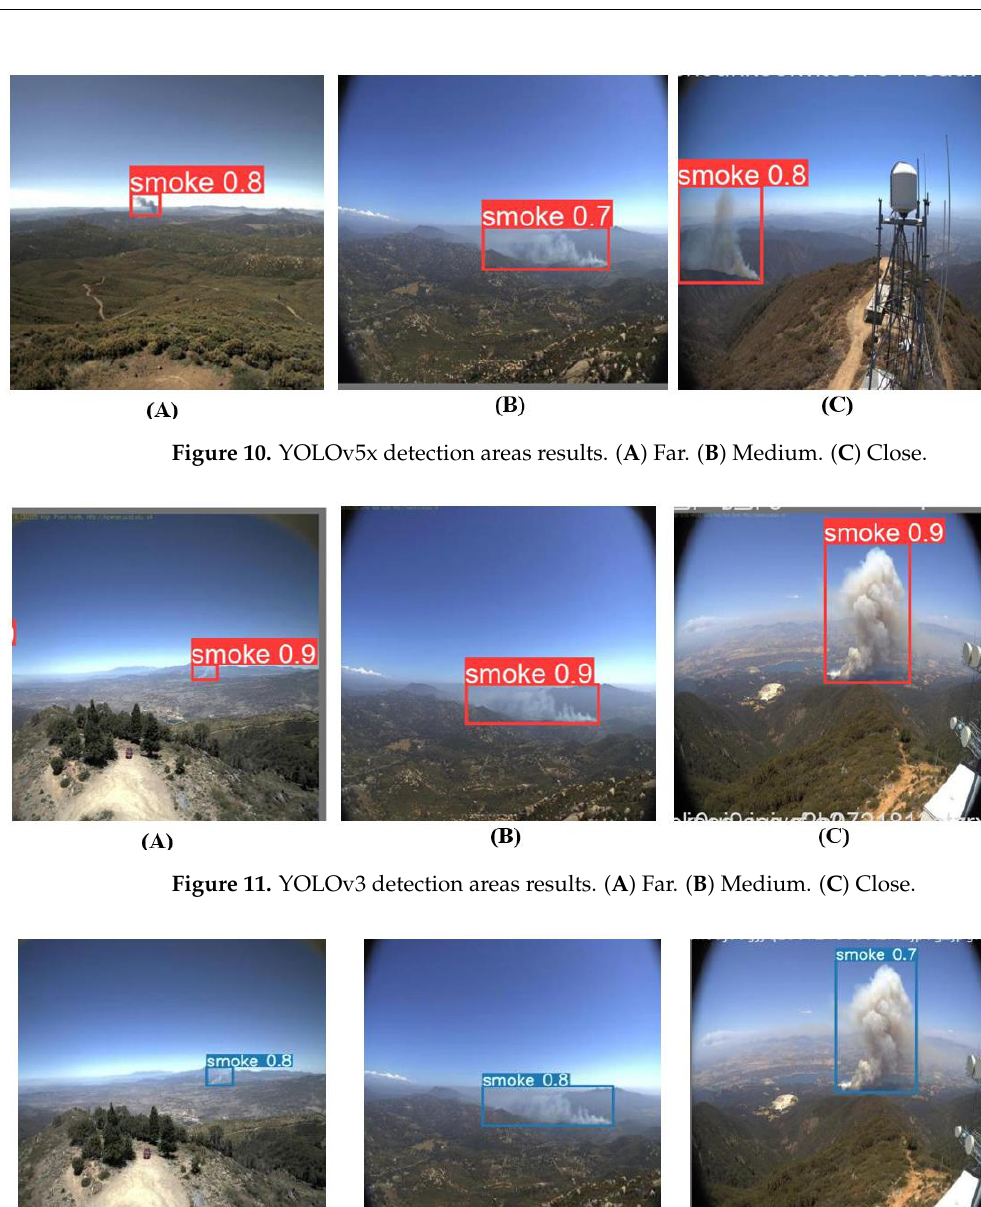
Figure 9. YOLOv5l detection areas results. ( A ) Far. ( B ) Medium. ( C ) Close.